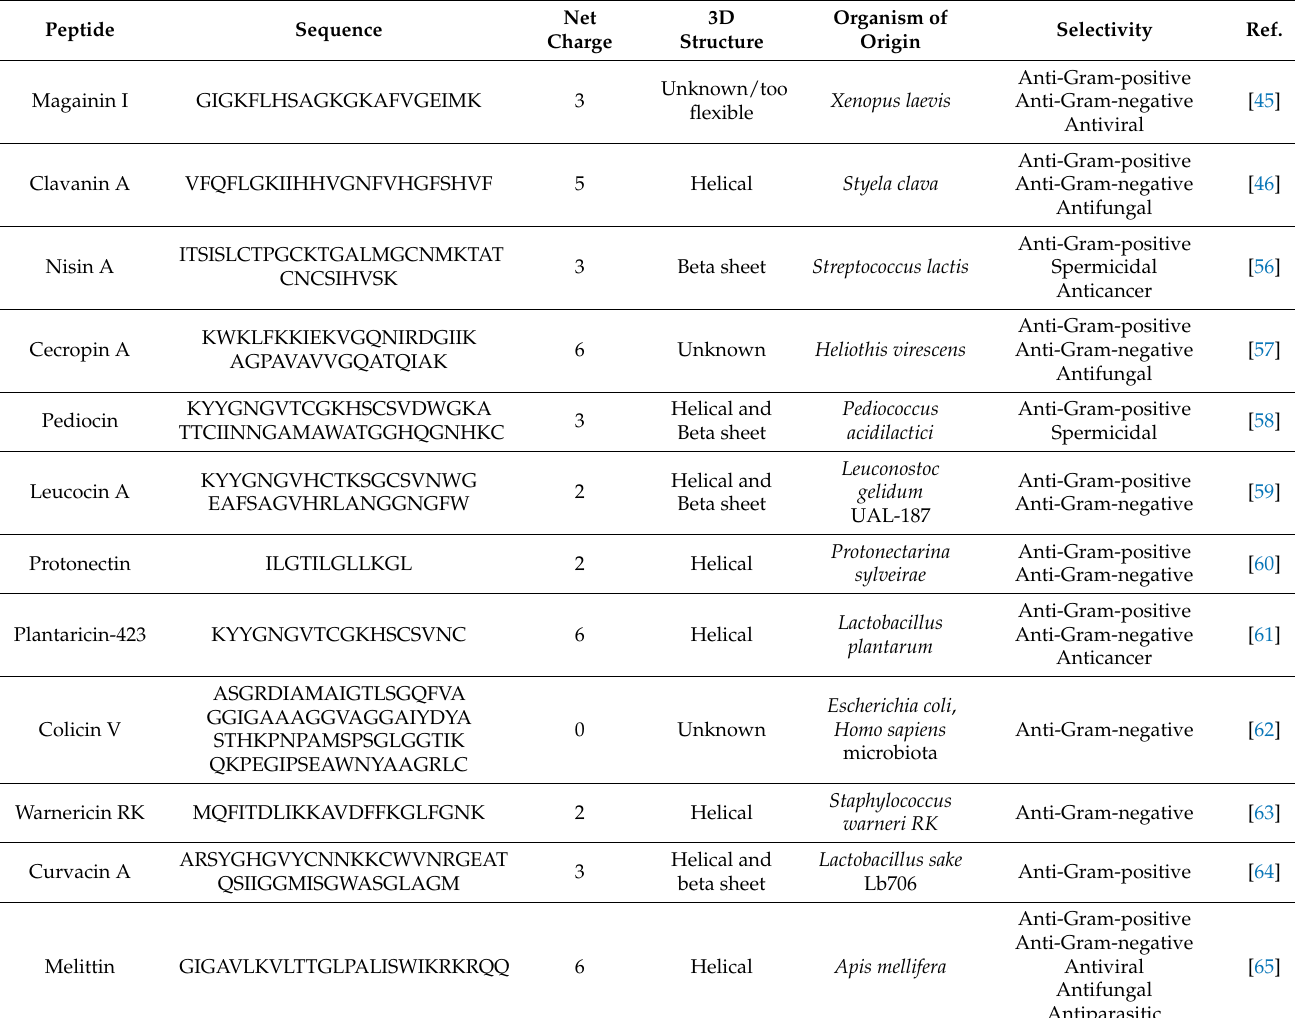
Table 2. Characteristics of natural antimicrobial peptides used in biosensors for foodborne pathogen detection